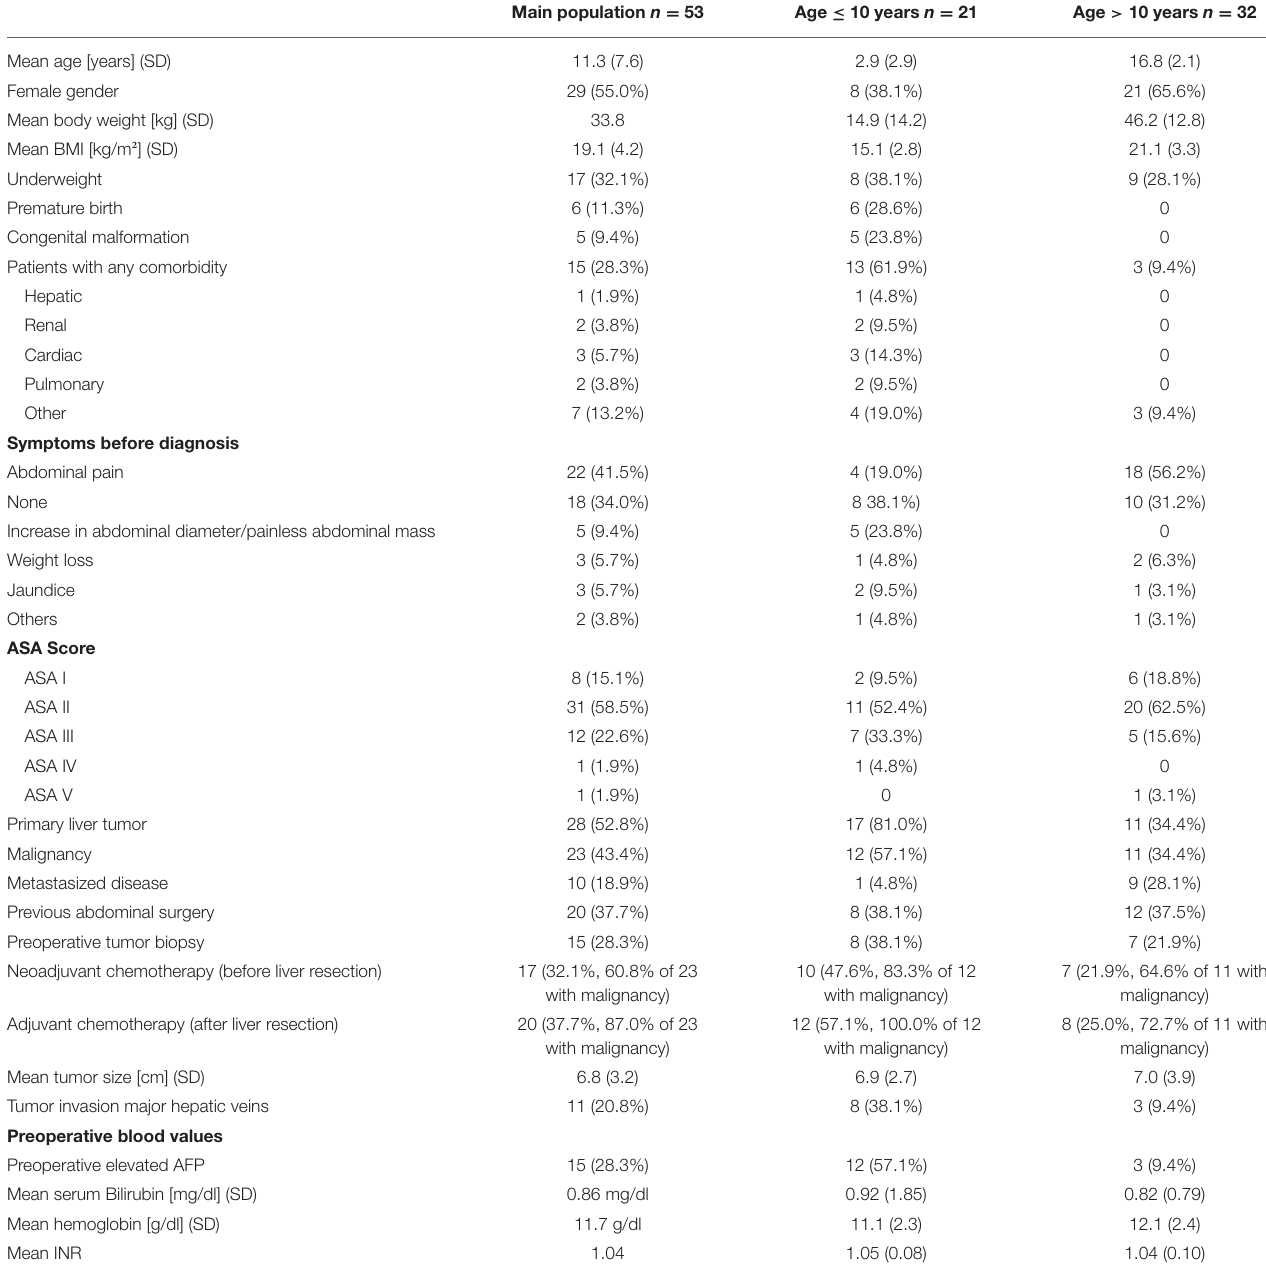
TABLE 1 | Patient